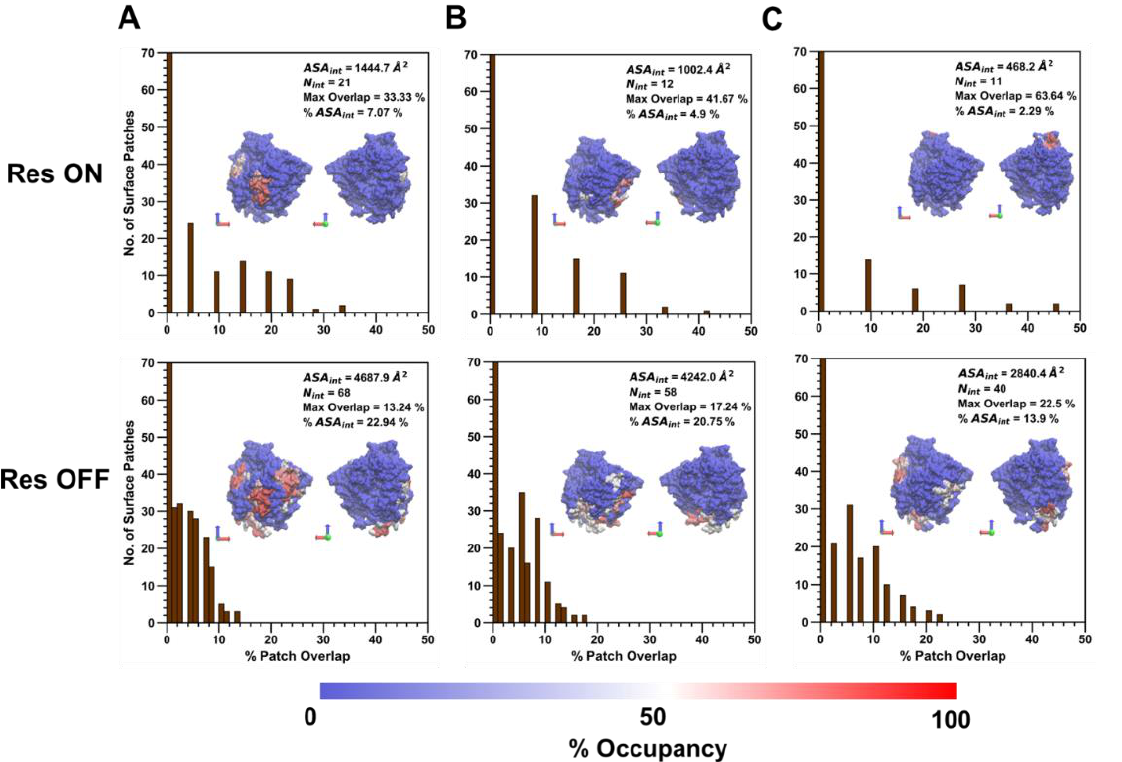
Figure 10. At low extension levels, the distribution of the number of contiguous surface patches that overlap with the collapsed averaged protein–polymer interface containing residues with >50% occupancy, at various overlap percentages, is shown for ( A ) PLGA/ID2S, ( B ) PEG/ID2S, and ( C ) PLGA-PEG/ID2S. Within each plot is the visualization of the collapsed interface, whereby red indicates the max occupancy and blue indicates no occupancy. ASA int is the surface area of the collapsed prot–poly interface, N int is the total number of residues in the collapsed interface, and % ASA int is the percentage of ID2S surface area that is composed of prot–poly collapsed interface. Max overlap value for each polymer/ID2S interface is also shown in each plot above.